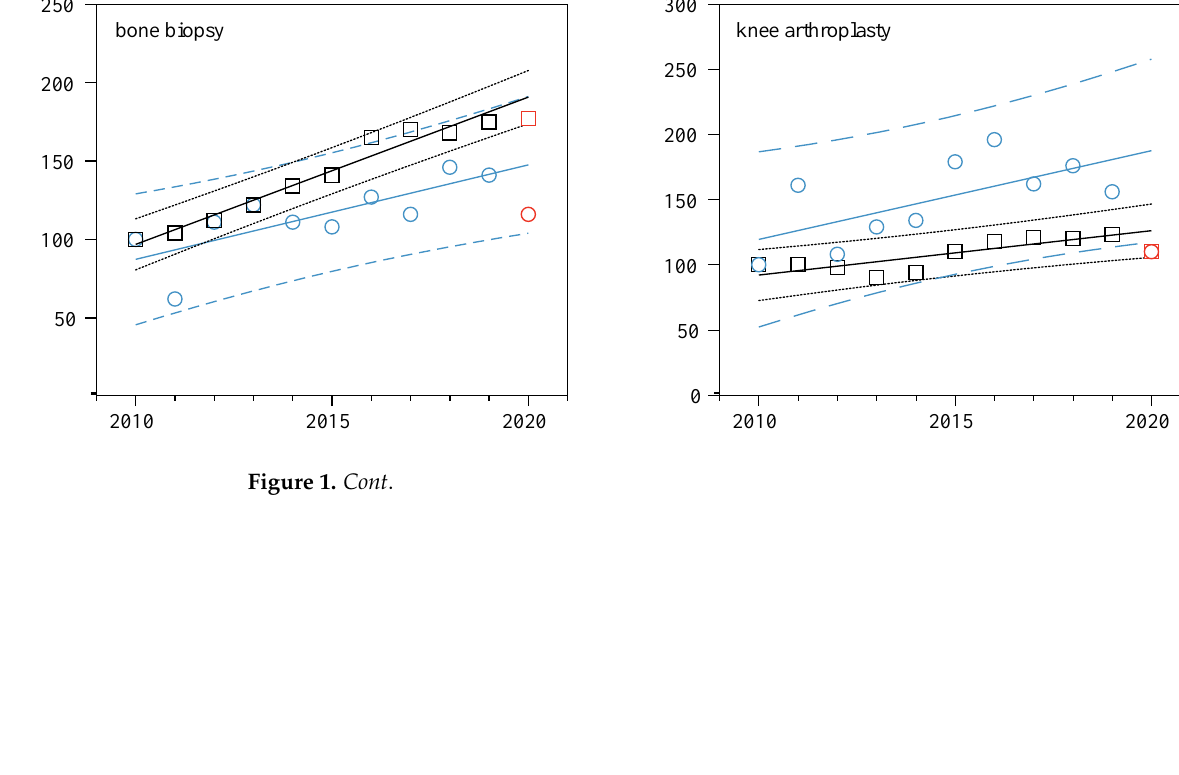
Figure 1. Relative change for each orthopedic procedure for the years 2010 – 2020. The relative count for each surgical procedure (bone biopsy, knee arthroplasty, hardware removal, arthrodesis, osteotomy, and foot surgery) was expressed as a fraction (in %) of each value (per year and group) divided by the corresponding value (per group) for the year 2010. Data for the non-DE group are given in the diagram with blue circles (“ ○ ” ), and data for the DE group are marked with black squares (“ ▢ ”). The straight blue line represents the linear regression of the non -DE group, whereas the straight black line illustrates the linear regression of the DE group. The 95% prediction intervals of each dataset are given as dotted lines (small dotted line for the DE group and big dotted line for